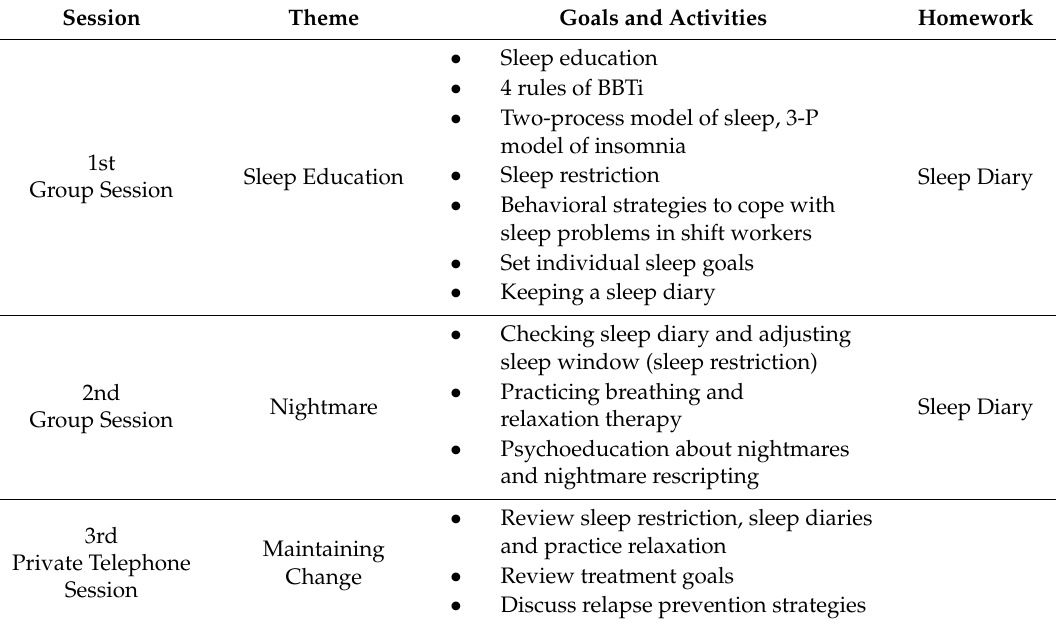
Table 1. Session-by-session protocol of Firefighter’s Therapy for Insomnia and Nightmares (FIT-IN).